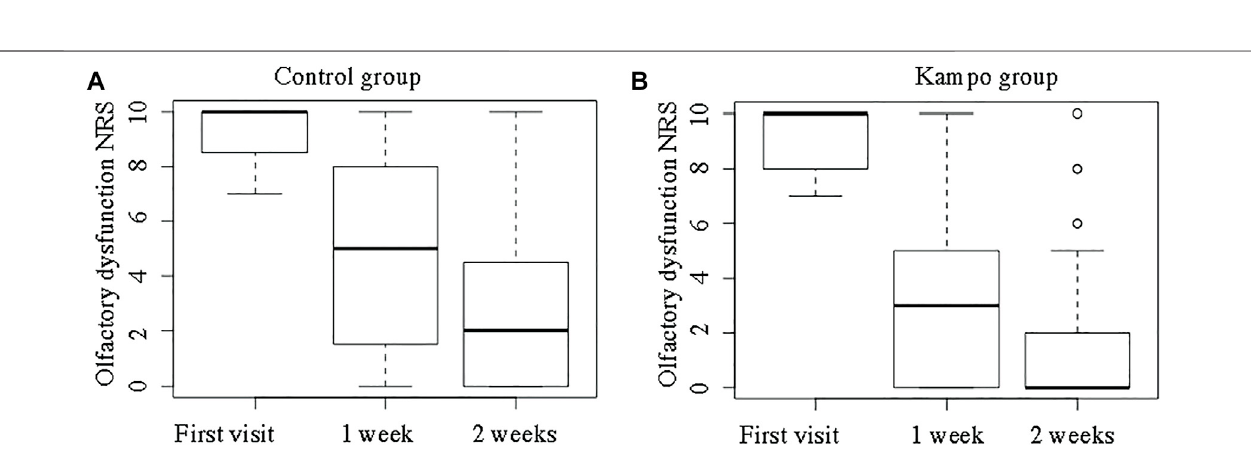
Frontiers in Pharmacology |